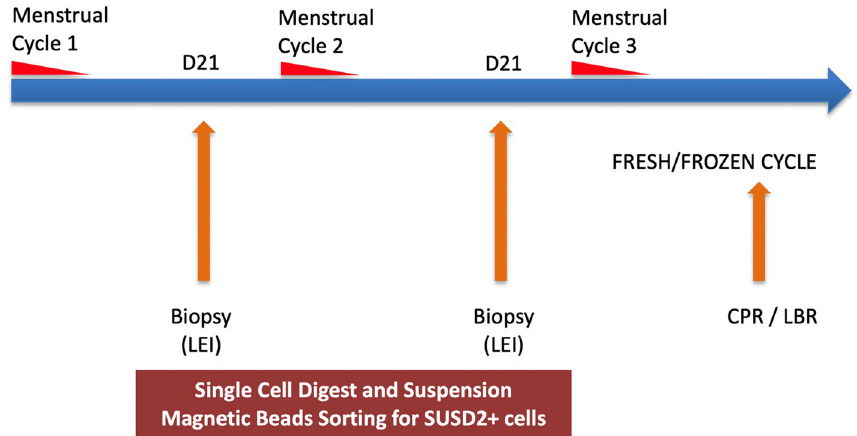
Figure 1. Timeline of endometrial pipelle sampling and experimental analysis. Legend: Local endometrial injury (LEI), Clinical pregnancy rate (CPR), Live birth rate